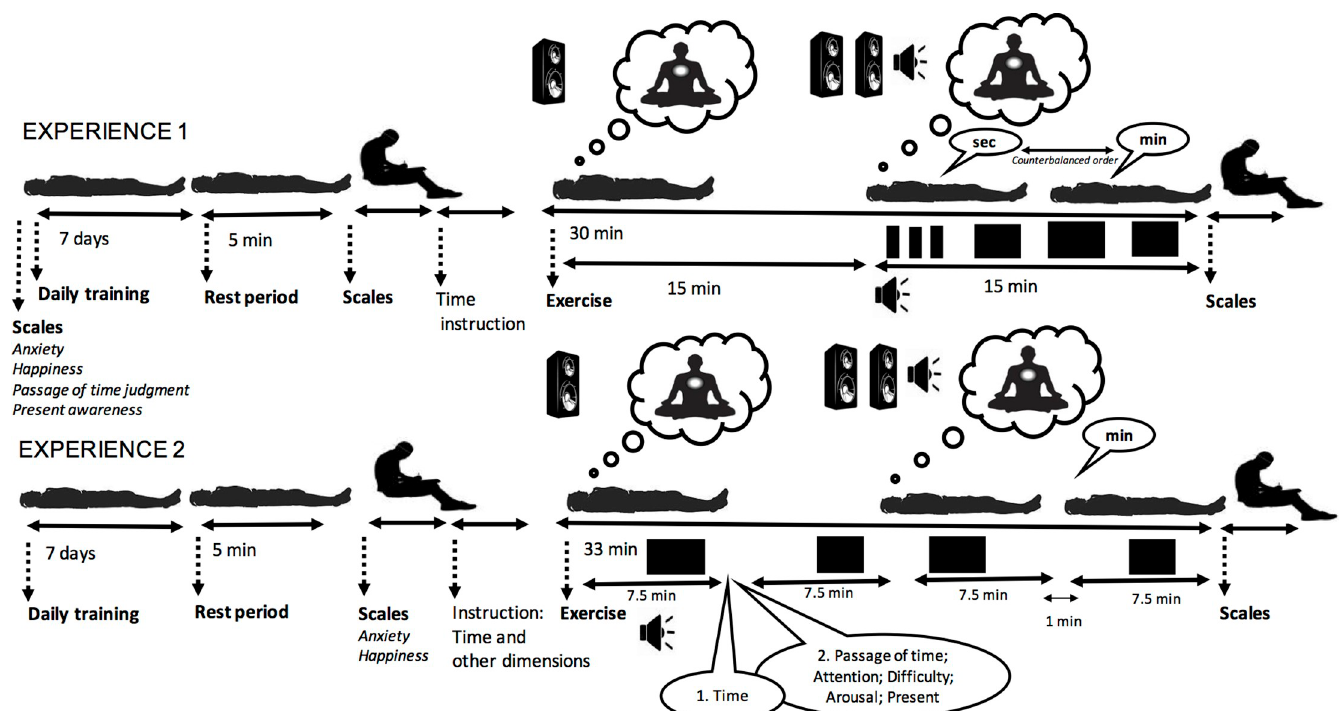
Fig 1. Experimental design. Schematic illustration of the procedure used in Experiments 1 and